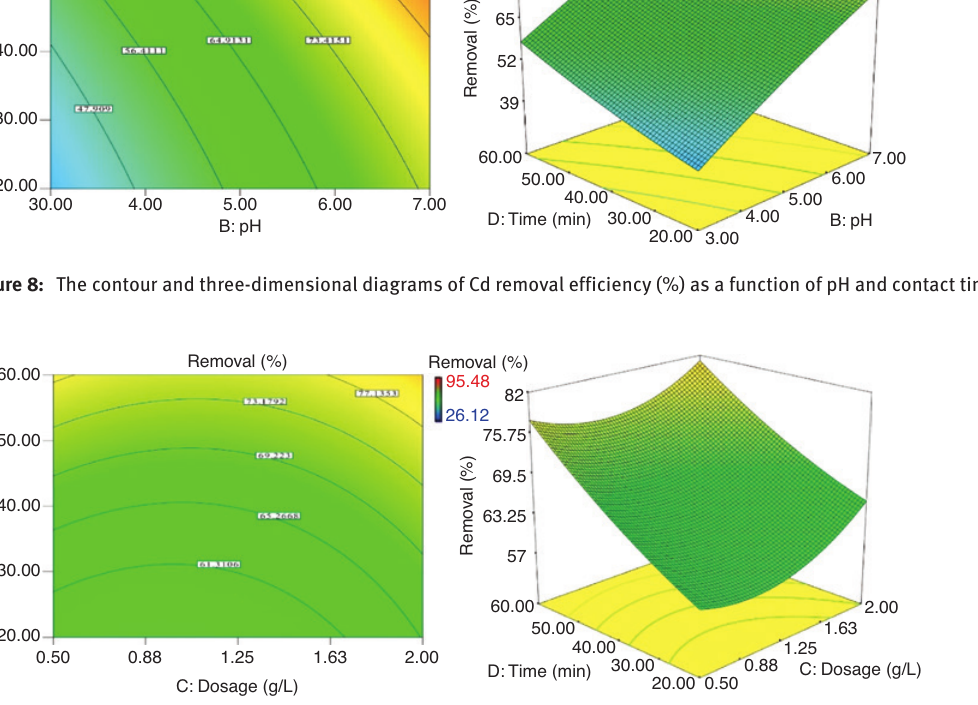
Figure 9: The contour and three-dimensional diagrams of Cd removal efficiency (%) as a function of contact time and adsorbent